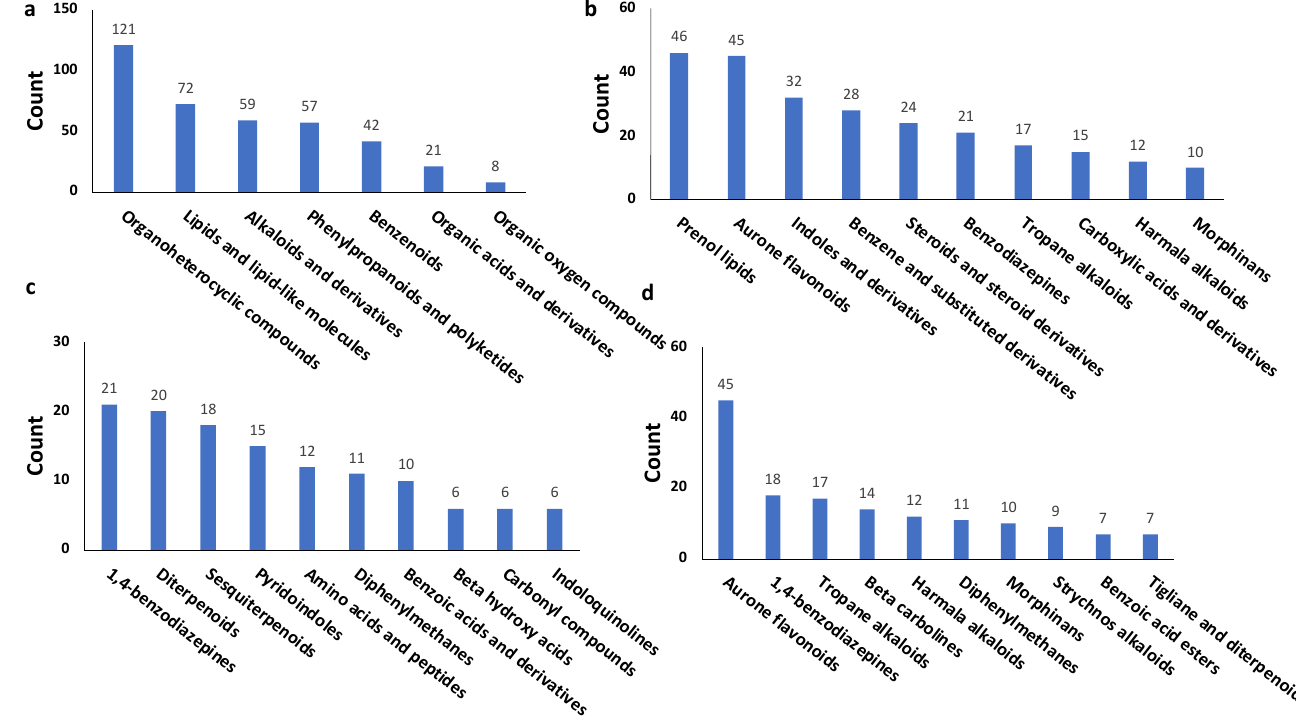
Figure 3. The top chemical categories represented within the 431 NP ligands identified as having potential to bind SARS-CoV-2 Mpro protein. ( a ) Chemical superclass, ( b ) Chemical class, ( c ) Chemical subclass, ( d ) Direct parent classification. Table 3. The selected top 20 NP ligands against 6LU7 M pro protein structure. The last three columns show binding affinities based on Autodock Vina, SwissDock, and CBDock docking